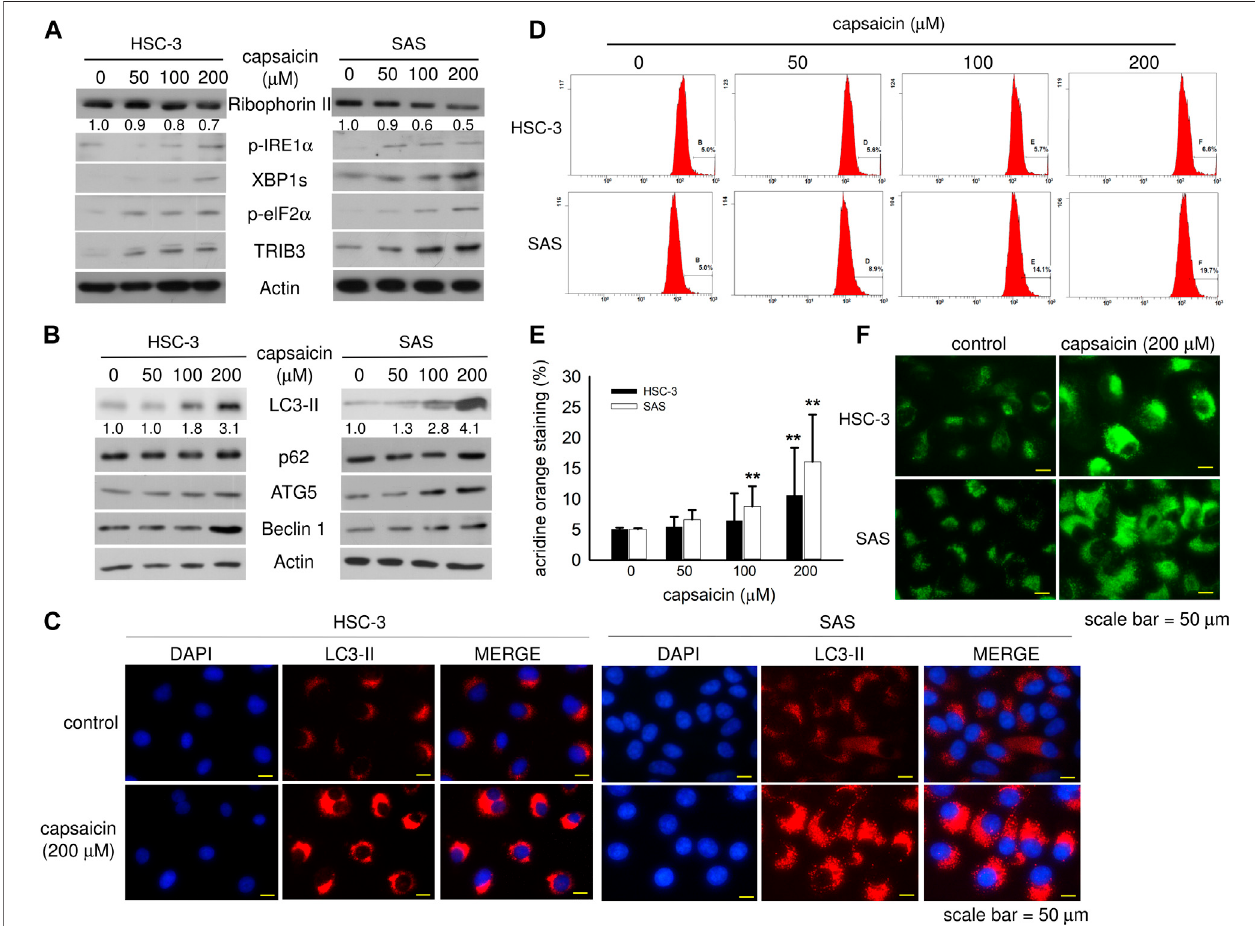
FIGURE 2 | Capsaicin dose-dependently down-regulates ribophorin II and enhances autophagy in HSC-3 and SAS cells. (A,B) Cells were treated with different concentrations of capsaicin for 48 h and the levels ofER stress- and autophagy-related proteins were measured by Westernblot analysis. (C) Cells were treated with or without 200 μ M capsaicin for 48 h followed by immuno fl uorescence staining to detect the levels of LC3-II. (D,E) Cells were treated with different concentrations of capsaicin for 48 h. The cells were then collected in microcentrifuge tubes and treated with 0.1 μ g/ml acridine orange for 30 min before being analyzed by fl ow cytometry. (F) Aftertreatmentwithcapsaicin,cellswerestainedwiththeDAPGreenreagent,asdescribedintheMaterialsandMethods.Dataarerepresentativeof fi veto ten independent experiments. Scale bar (cid:2) 50 μ m.